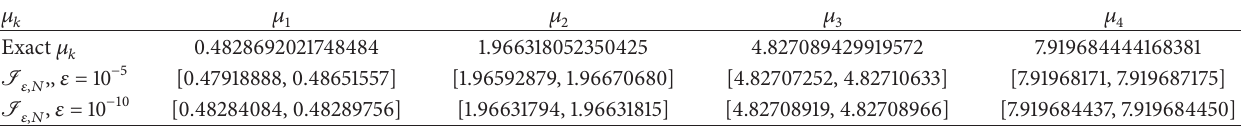
Table 7: For 𝑁 = 40 , 𝑚 = 14 and 𝜃 = 1/26 , the exact solution 𝜇 𝑘 are all inside the interval [ 𝑎 − , 𝑎 + ] for different values of 𝜀